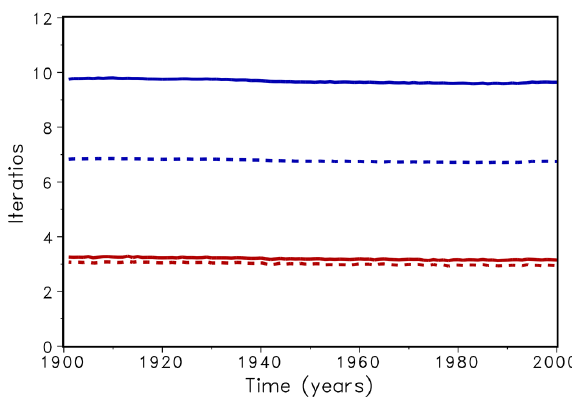
Figure 2. Average number of iteration for bisection (upper lines, blue) and Newton (lower lines, red) for accuracy x acc = 0 . 01 (dot- ted) and 0.001 (solid).